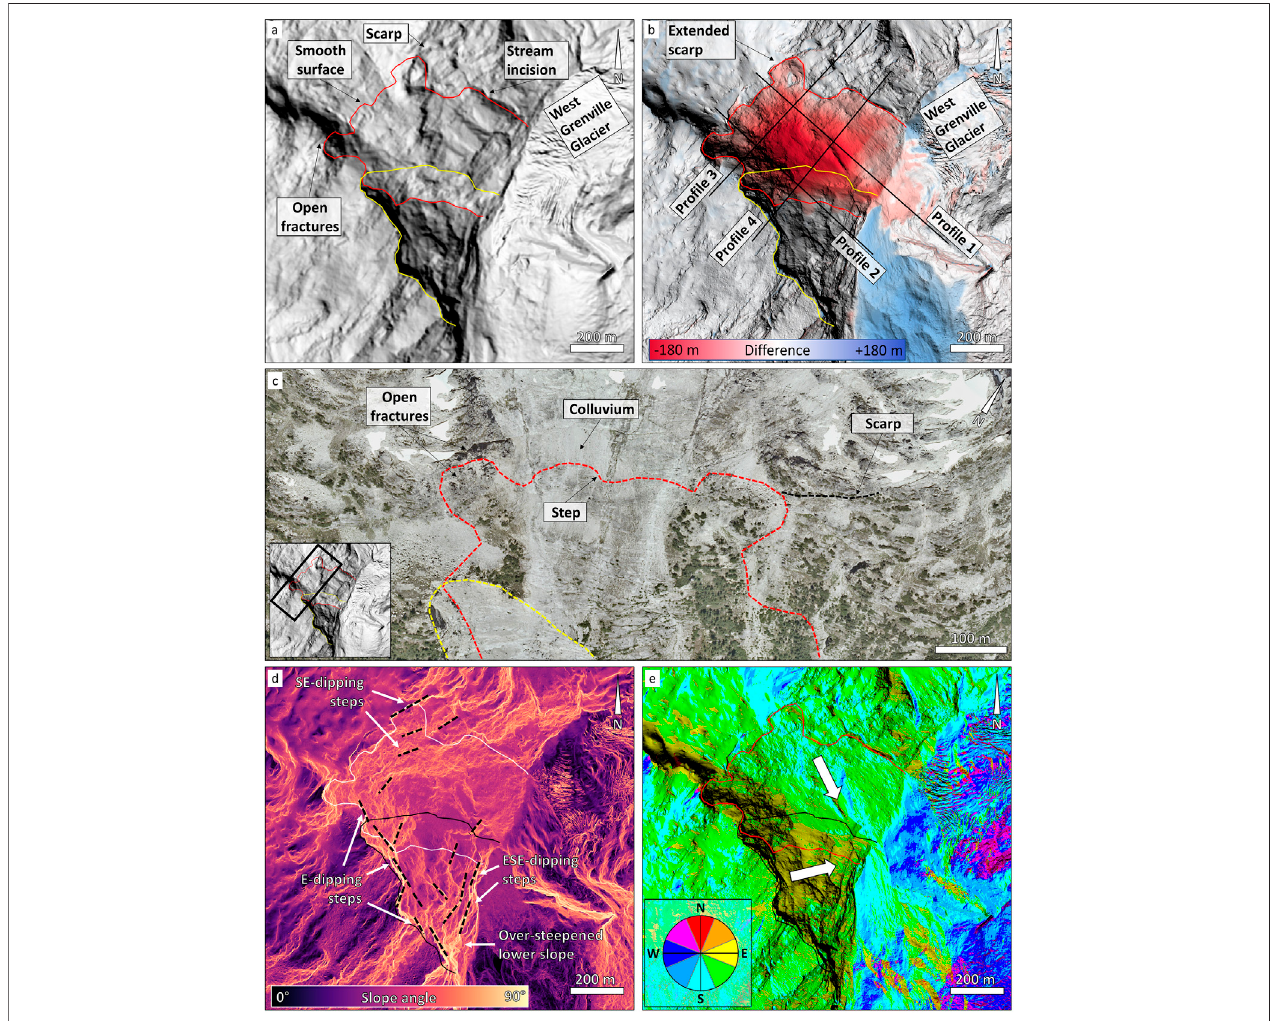
FIGURE3 | Comparison ofpre- and post-failure datasets. (A) Pre-failure hillshade map. Theyellowand red curves outlinethe surface area ofthe old and the 2020 landslideevent, respectively. Note the void leftbythe older landslide tothesouth, and thestreamincision that marksthe opposite sideofthe landslide volume. (B) Post- failure hillshade map, overlayed with the difference with the pre-failure LiDAR dataset. Red and blue shades represent elevation loss and gain, respectively. Pro fi les 1 – 4 are displayed in Figure 5 and discussed in the text. (C) Detail of a 2006 aerial photo showing the upper landslide area. Note the stepped, incipient rupture surface (red dashed line) that intersects areas with open fractures and colluvium cover. The scarp extended during the 2020 landslide is also highlighted. (D) Post-failure slope map,showingthesteepeningofthegroundsurfaceinthelowerslope,andthevarieddippingofthemainstepsets.NotetheE-dippingstepsthatcontrolandpartlyform the southern boundary of the older landslide area. (E) Post-failure aspect map. Note the older landslide area, characterized by an overall ENE dip direction, and the scar of the 2020 landslide event, for the most part dipping to the SE.